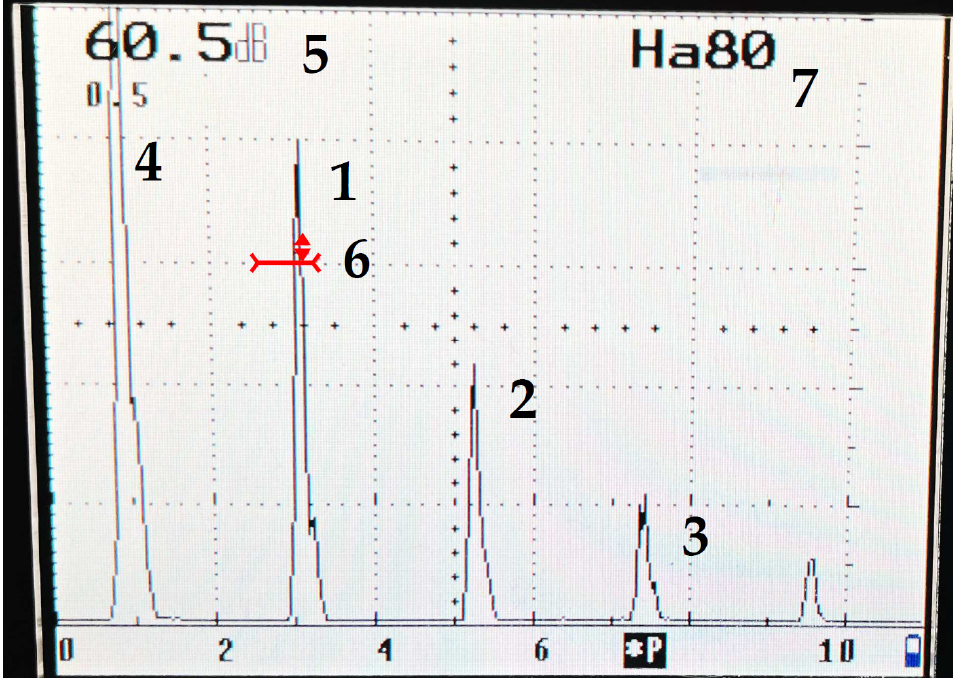
Figure 3. Ultrasonic flaw detector; 1—first pulse (H I ), 2—second pulse (H II ), 3—third pulse (H III ), 4—transmit impulse, 5—gain, 6 —gate (red color), 7—amplitude value of gate pulse.